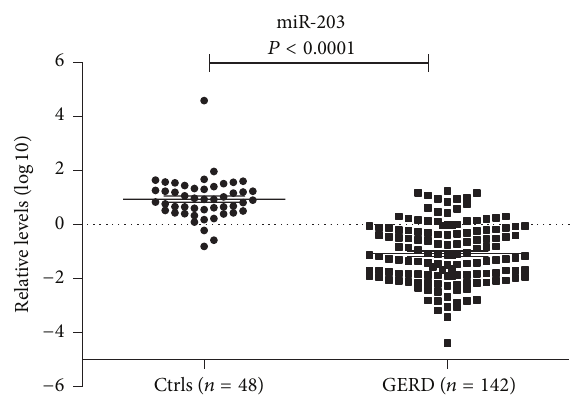
Figure 2: miR-203 expression in patients with GERD and Ctrls. The levels of miR-203 in exfoliated cells of the tongue were evaluated by qRT-PCR in patients with GERD ( 𝑛 = 142 ) and Ctrls ( 𝑛 = 48 ). The median level of expression is represented in each group by a solid line.ThevaluesarenormalizedtoU6expressionlevelsanddisplayed in log 10 scale on 𝑌 -axis.